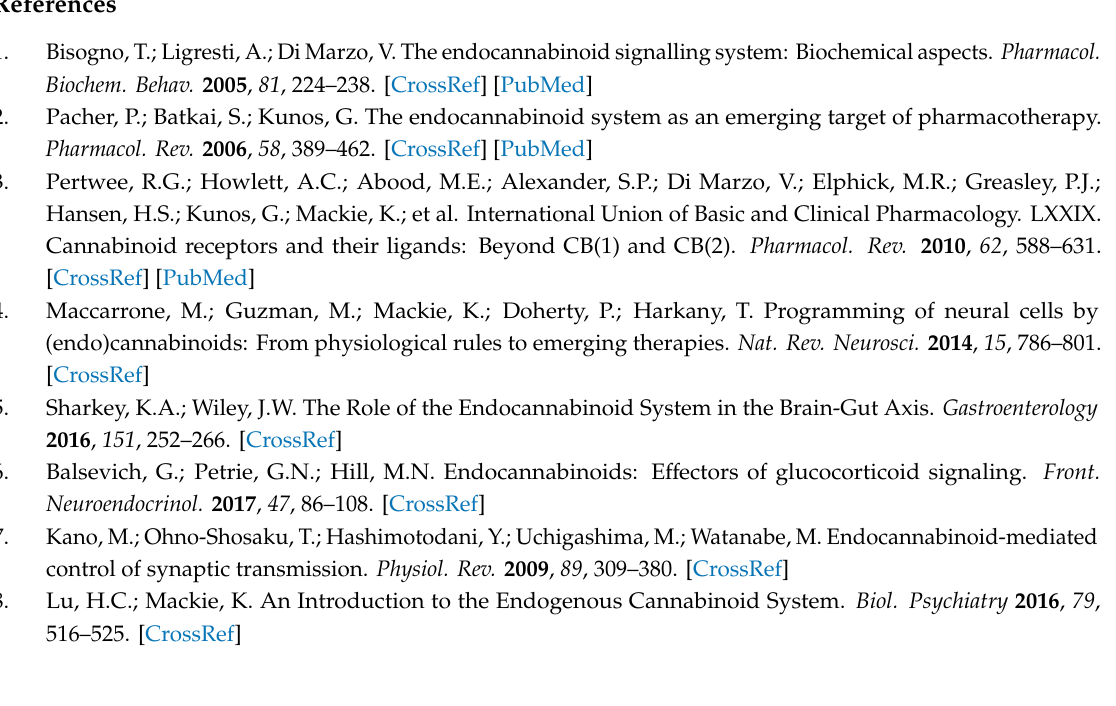
Figure S1: E ff ects of PF3845 and the CB receptor antagonists on ROS production. Author Contributions: Methodology, M.T. and K.Z.; Validation, M.T., K.Z. and S.S.; Formal analysis, M.T. and K.Z.; Investigation, M.T., K.Z. and S.S.; Writing—Original draft preparation, M.T.; Writing—Review and editing, M.T., S.S. and Y.Z.; Visualization, M.T.; Supervision, Y.Z.; Funding acquisition,